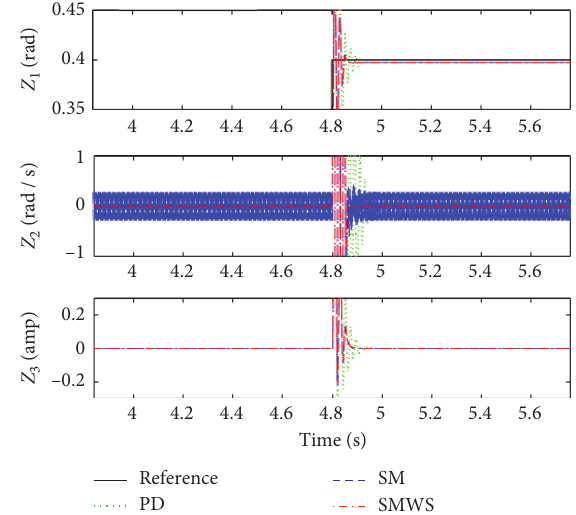
Figure 12: A zoom in the states of the second electricity generator.